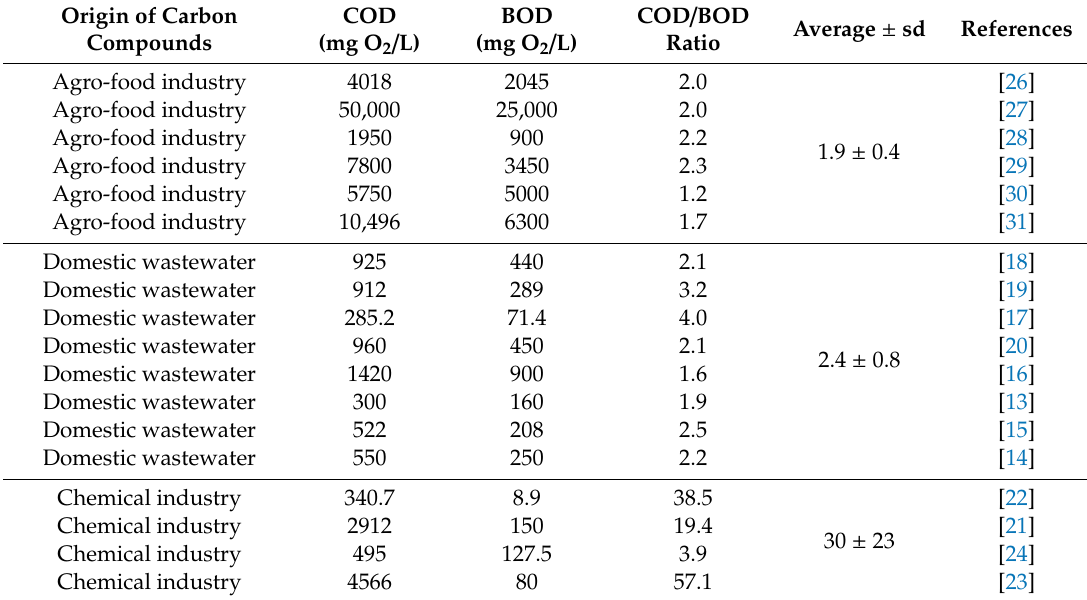
Table 1. Biodegradability of wastewater with respect to organic compounds: comparison between agro-food industry, domestic, and chemical industry